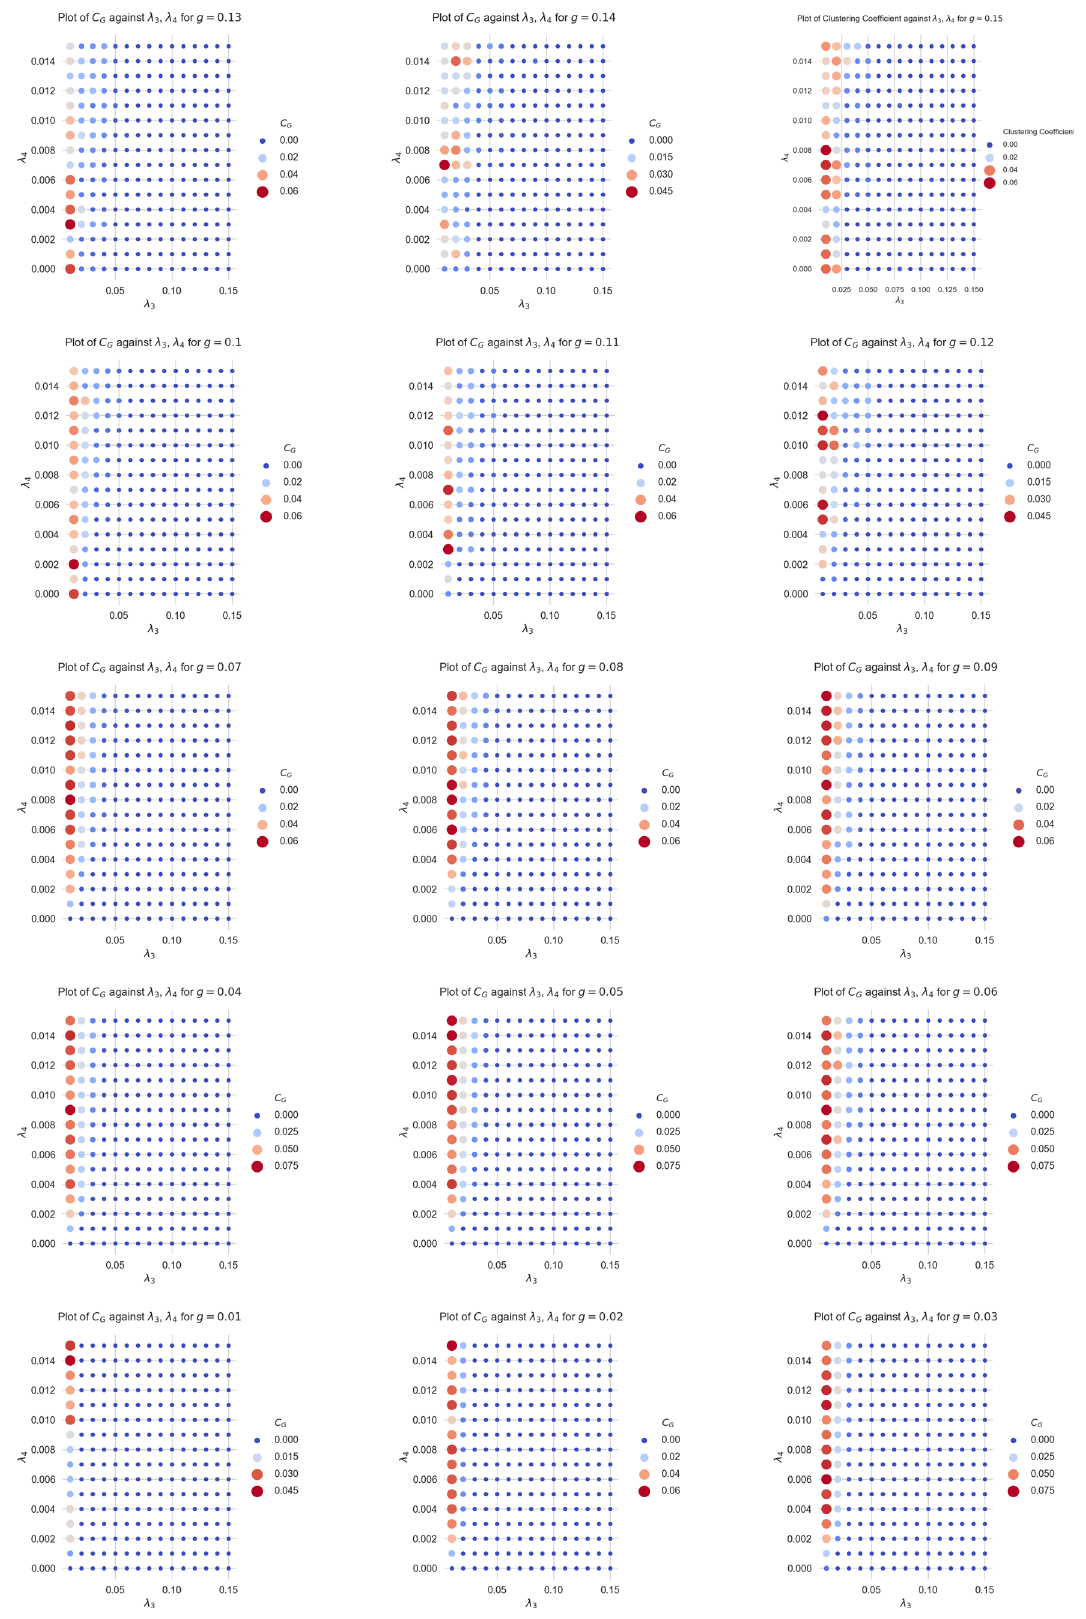
Fig. 9 For a mesh of N = 50 the clustering coefficient is measured computed from the ground state of Eq. (8), across a range of values of λ 3 , λ 4 from 0 . 0 to 0 . 15. Clustering coefficient decreases as λ 3 , λ 4 increases, but λ 4 = 0 is most